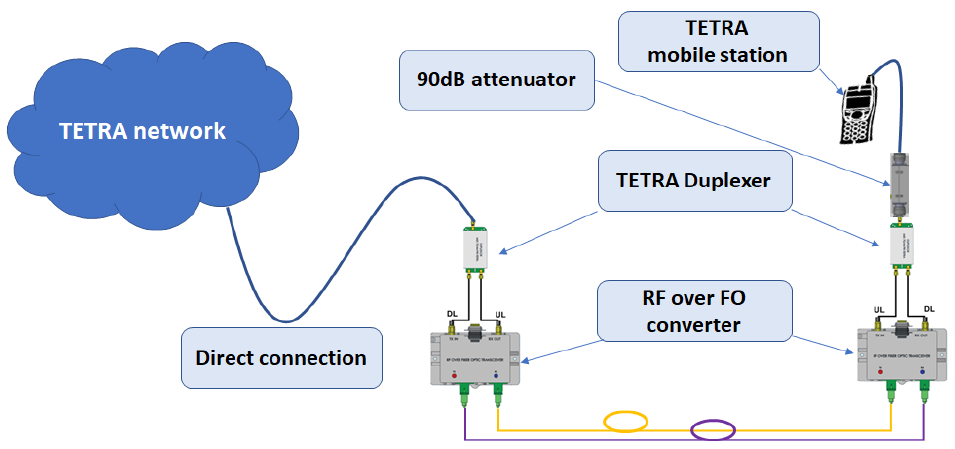
Figure 6. Testbed for 2 km radiating cable